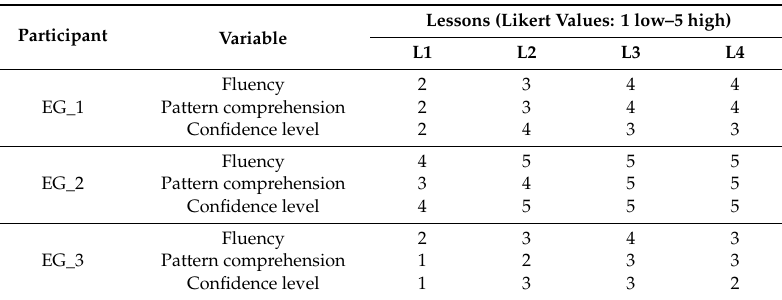
Table 7. Variables observed by